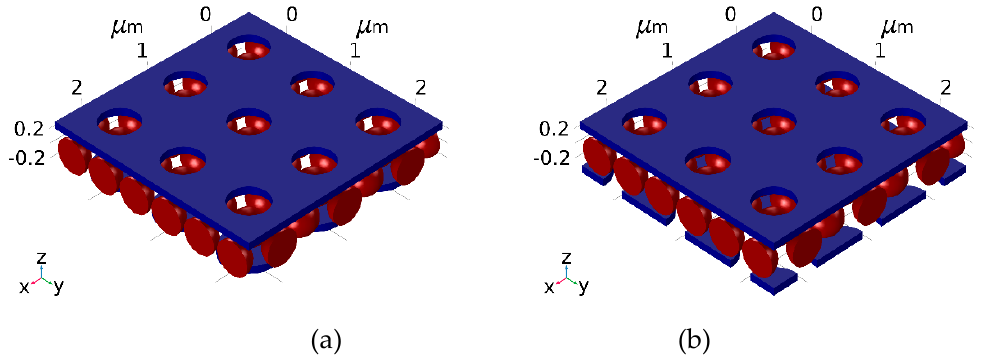
Figure 1. Cross section of a bi-layer metallo-dielectric screen. The top (front) metal screen is made of a hole-array; the bottom (back) screen is made of metallic disks and the gap is filled with dielectric-embedded silica colloids. ( a ) Un-shifted construction: The disk-array is centered below the hole-array. ( b ) Shifted structures: The disk array is diagonally shifted along the x-y direction by half a pitch with respect to the hole-array.